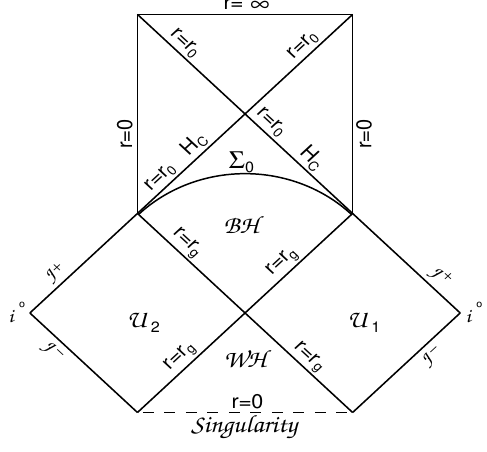
Figure 1. Penrose–Carter diagram for the case of the direct de Sitter–Schwarzschild matching. J − and J + are the past and future null (photon) infinities, while i 0 is the spacelike infinities.